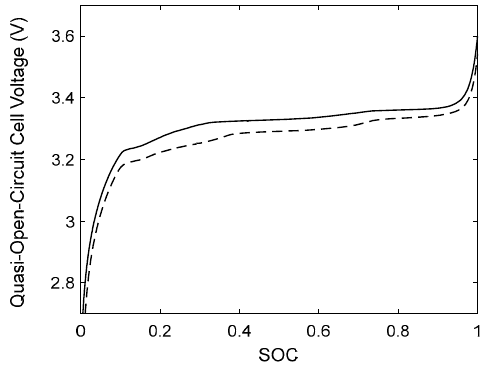
Figure 4. Quasi-open-circuit voltage of the cell as a function of the state of charge ( SOC ) obtained at C n /50 for a complete charge/discharge cycle. Solid line: Charge trajectory. Dashed line: Discharge trajectory.